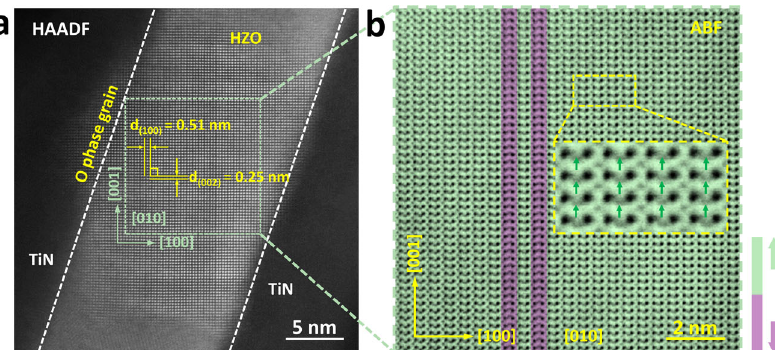
Fig. 3 The observation of O AFE Pbca phase returning to O FE Pbc 2 1 phase after wake-up process. a Cross-section STEM-HAADF image of the TiN/HZO/ TiN device after wake-up under the bipolar triangle pulses of ±4 V, 10 4 cycles with f = 500 kHz, in which a [010] oriented HZO O-phase grain is examined. b ABF image acquired from the green square area in a , the majority of the off-center O II atomic columns shifted along the [001] direction (green), demonstrating a Pbc 2 1 -dominated phase structure after the wake-up. The inset magni fi ed ABF image shows the shifting direction of O II atomic columns deviating from the center of the four nearest Hf/Zr columns, fi tting well with Pbc 2 1